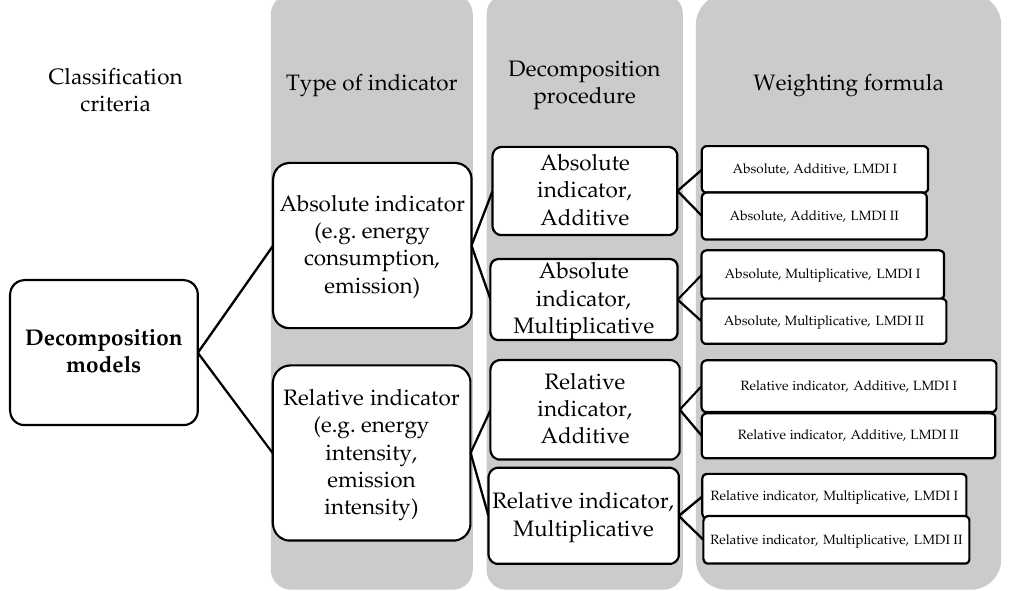
Figure 1. Eight types of Logarithmic Mean Divisia Index decomposition models. Source: Adapted from reference [14].